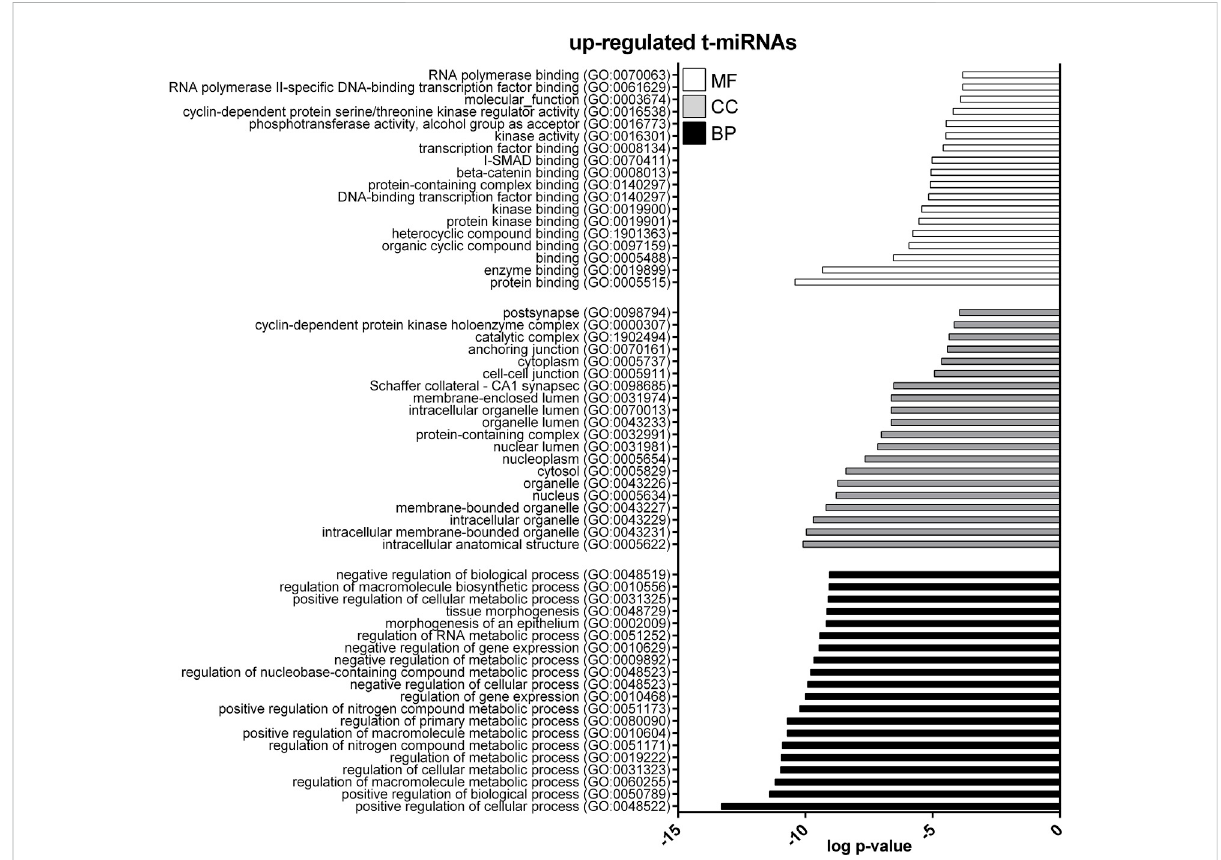
FIGURE 4 Gene ontology (GO) of predicted target genes for up-regulated t-miRNAs. GO of the 161 target genes predicted for up-regulated t-miRNAs performed with Panther ver 17.0 (http://www.pantherdb.org/). Genes were classi fi ed based on biological processes, cellular component, and molecularfunction.The fi rst20mostenrichedcategorieswereshown.Statisticaloverrepresentationtestsshowingthe p -valueofeachcategoryare shown in Supplementary Table